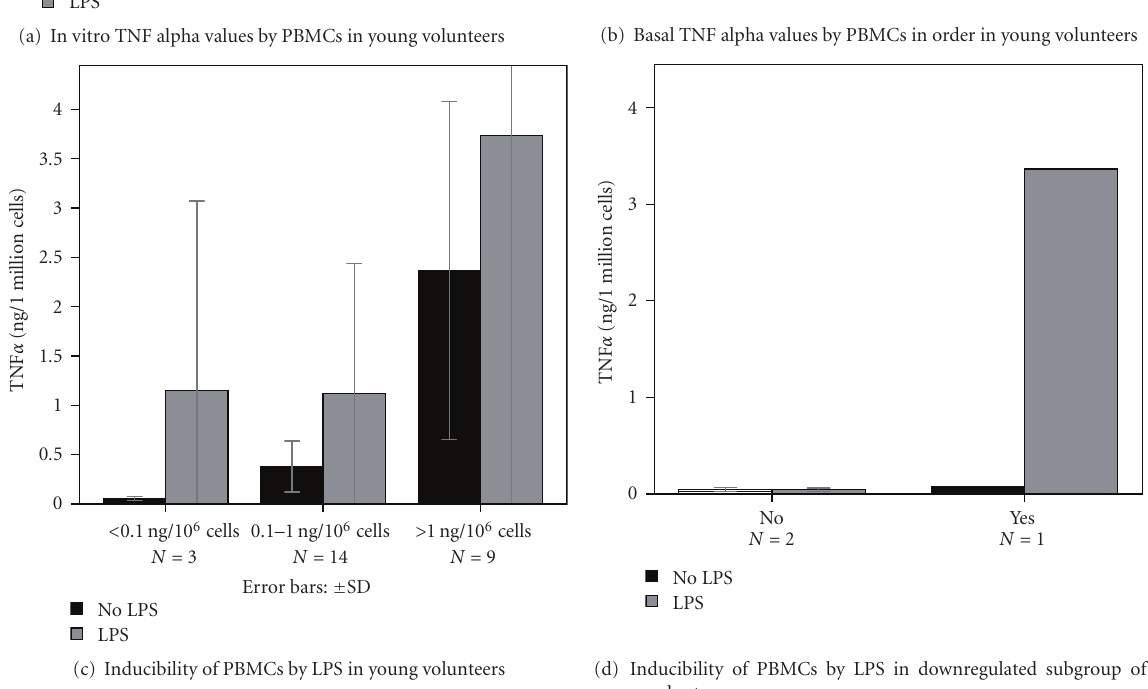
Figure 4: In vitro TNF α productions by peripheral blood mononuclear cells (PBMCs) of young volunteers demonstrate significant inter- individual di ff erences in this group (a) based on the order of TNF α production (b) three subgroups can be distinguished: down-regulated, intermediate, and upregulated (c) no response to endotoxin (LPS) was found in the majority of downregulated group (d), ∗ P < 0 . 05 stimulated versus